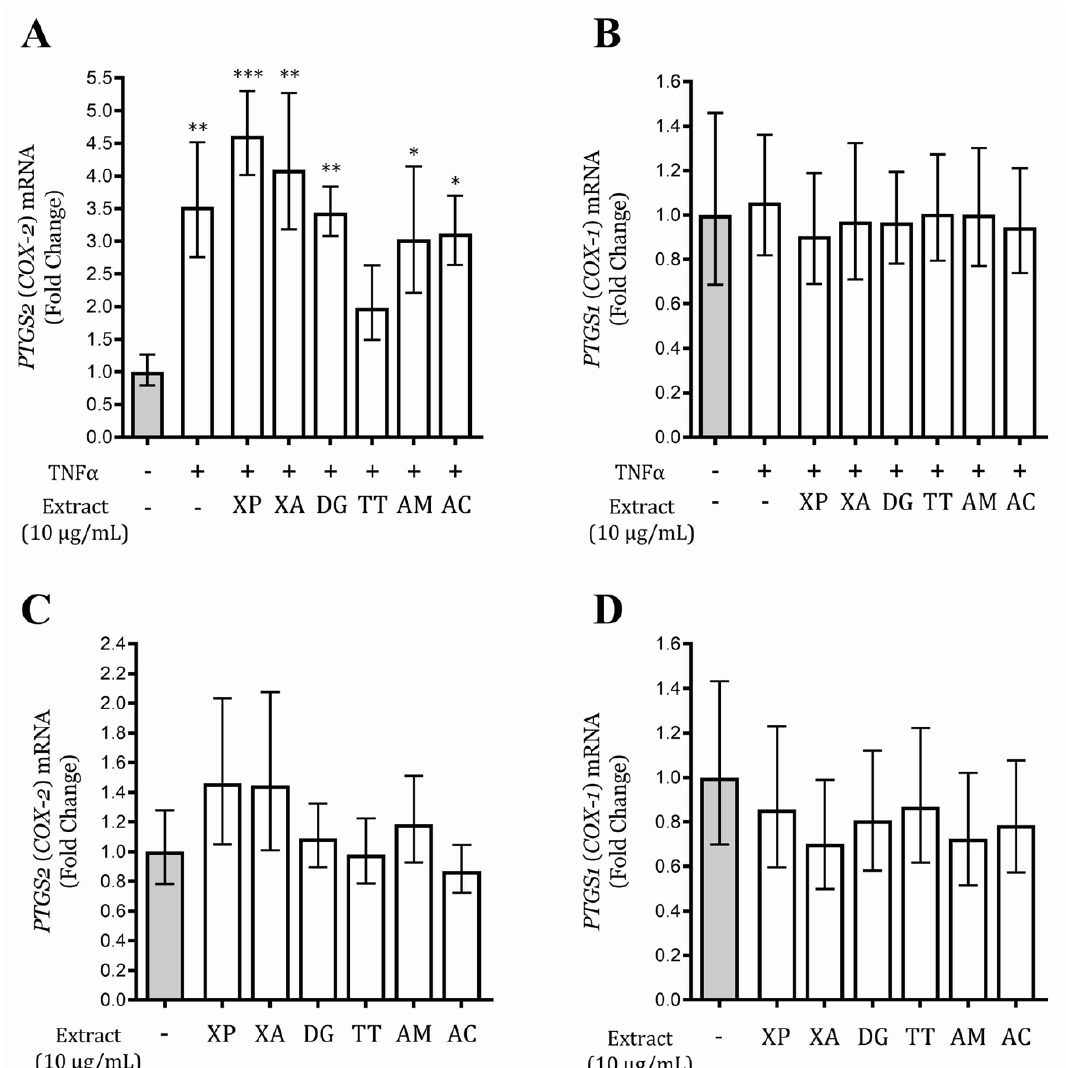
Figure 5. E ff ect of the extracts on prostaglandin endoperoxide synthase 2 PTGS2 ( COX-2 ) and prostaglandin endoperoxide synthase 1 PTGS1 ( COX-1 ) mRNA levels in the presence ( A , B ) or in the absence ( C , D ) of TNF α , in gastric epithelial (GES-1) cells. Data are expressed as fold changes versus control (grey bar). * p < 0.05; ** p < 0.01; *** p < 0.001.